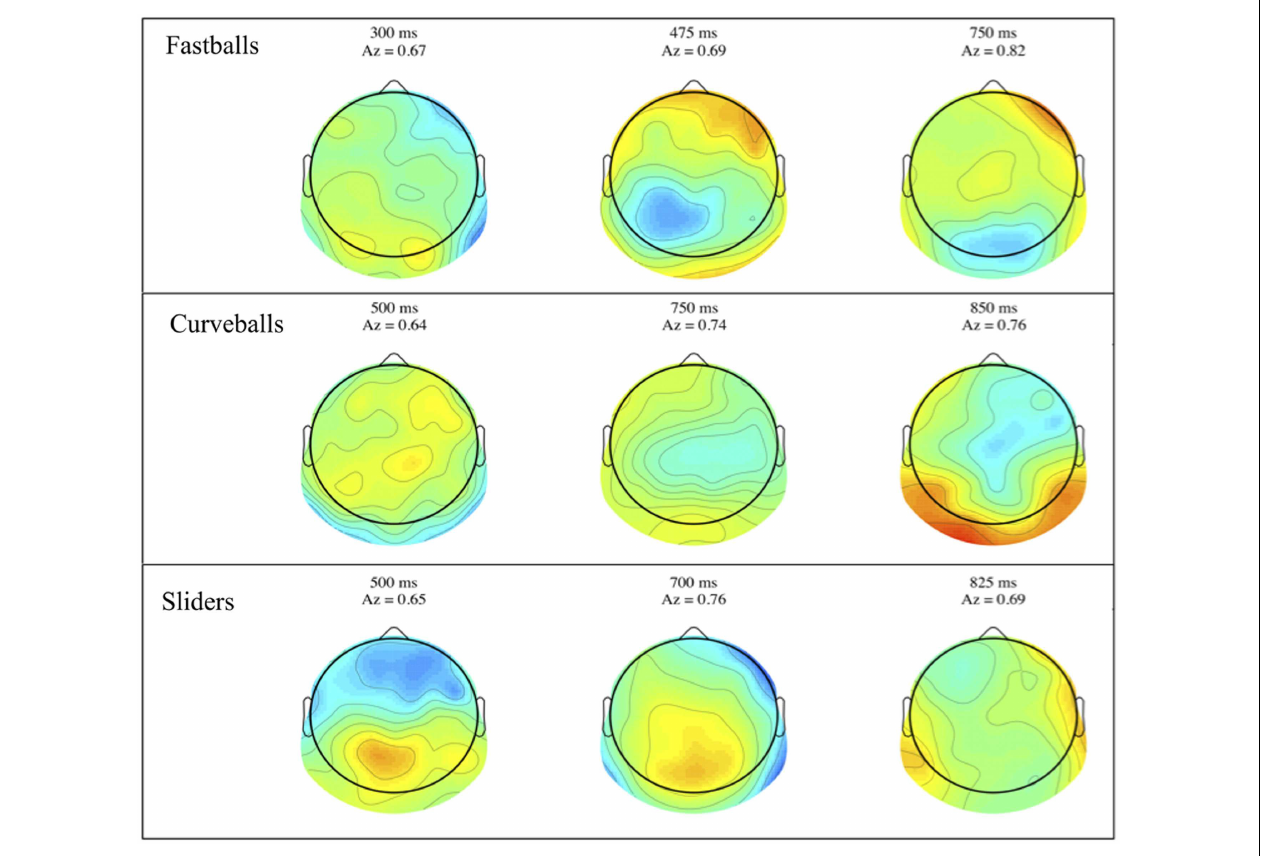
FIGURE 3 | Group averaged stimulus-locked forward models, shown as scalp maps, for each of the three pitch types. Only behaviorally correct trials are used to estimate these forward models. For each pitch, three time